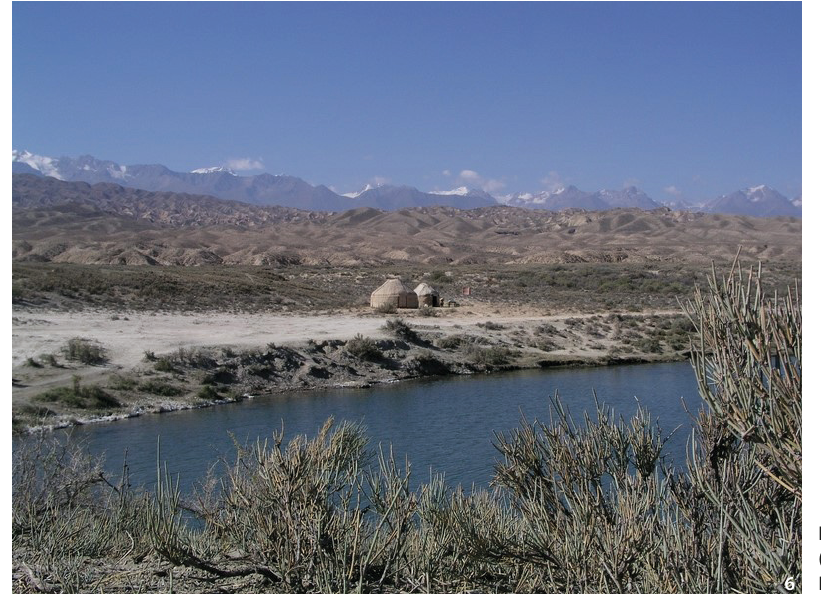
Figure 6 Cultural Landscape of Issyk Kul Lake (Kyrgyzstan) along the Silk Roads (Source: Yuri Peshkov).